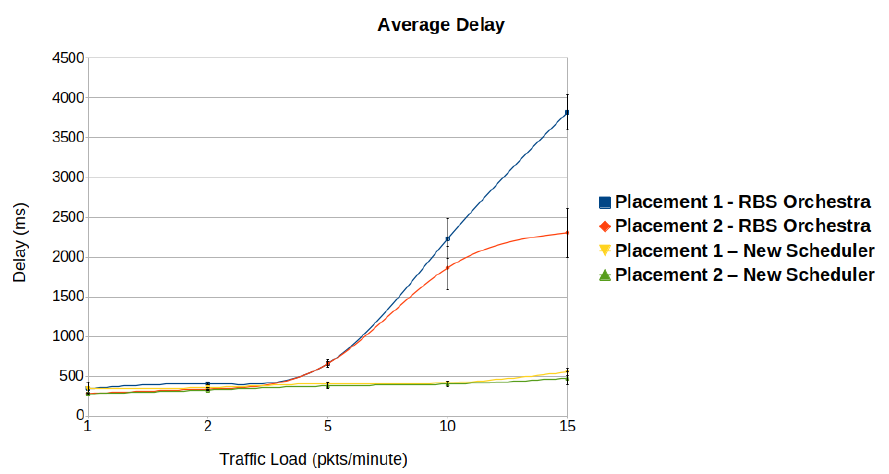
Figure 11. We observe that when it comes to average delay, the new scheduler performs better than Orchestra, in high traffic